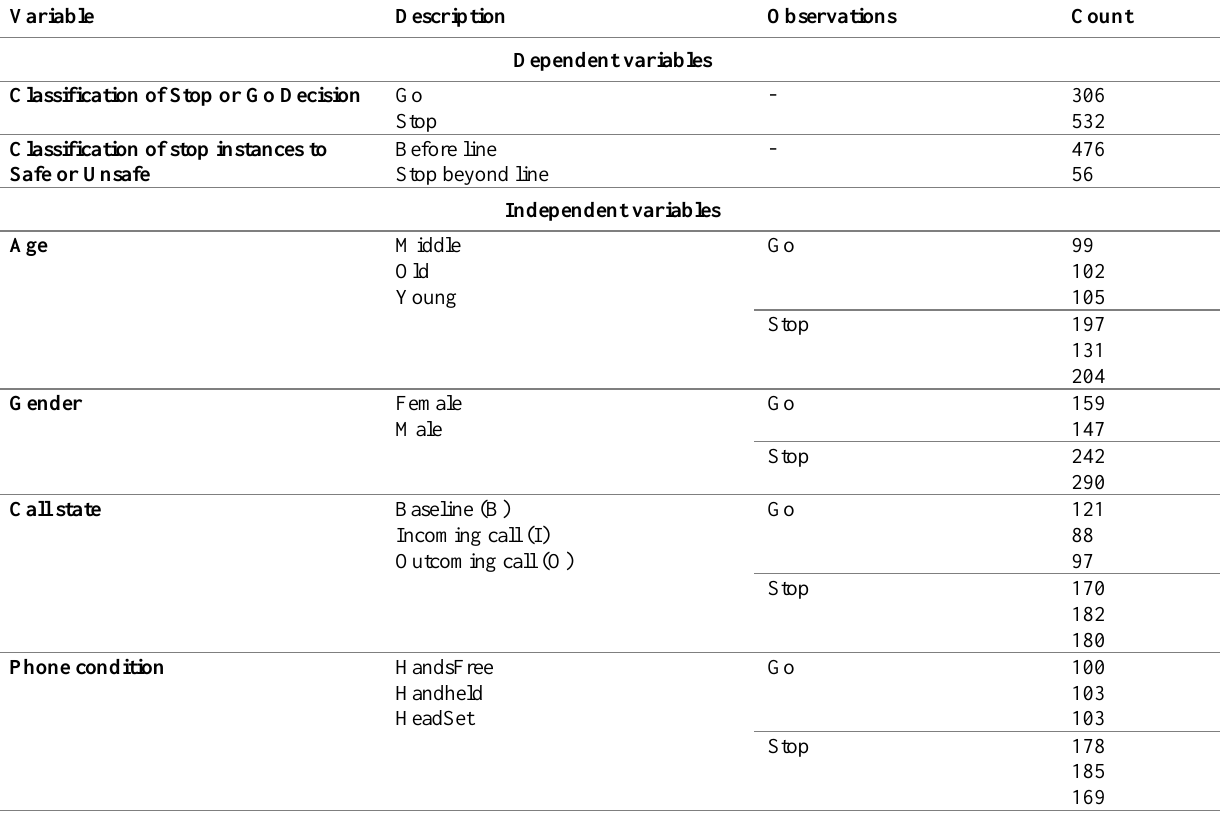
Table 3 . Description of dependent and independent variables (discrete).